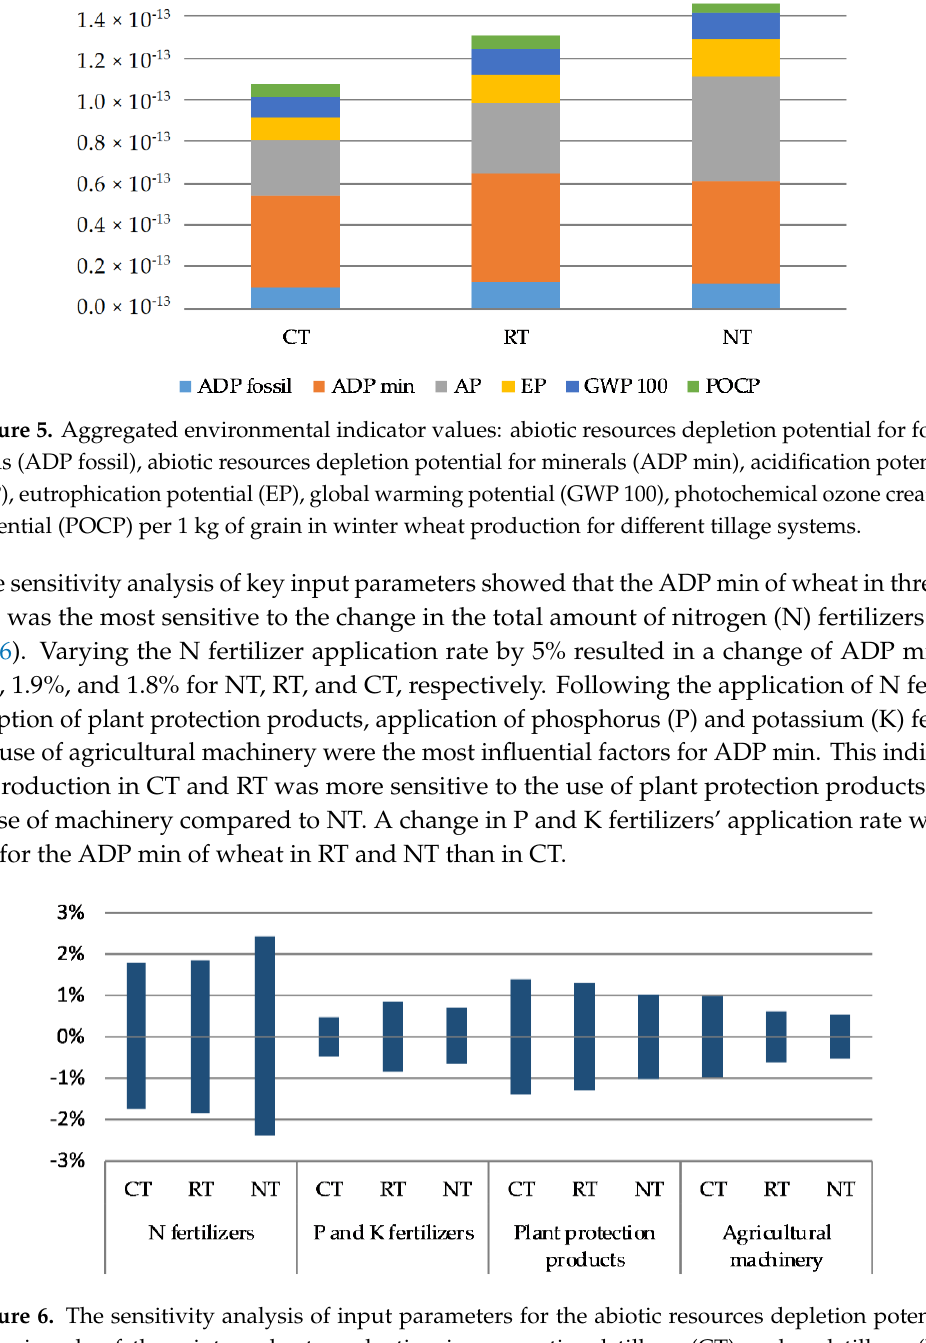
Figure 6. The sensitivity analysis of input parameters for the abiotic resources depletion potential for minerals of the winter wheat production in conventional tillage (CT), reduced tillage (RT), and no-tillage (NT).